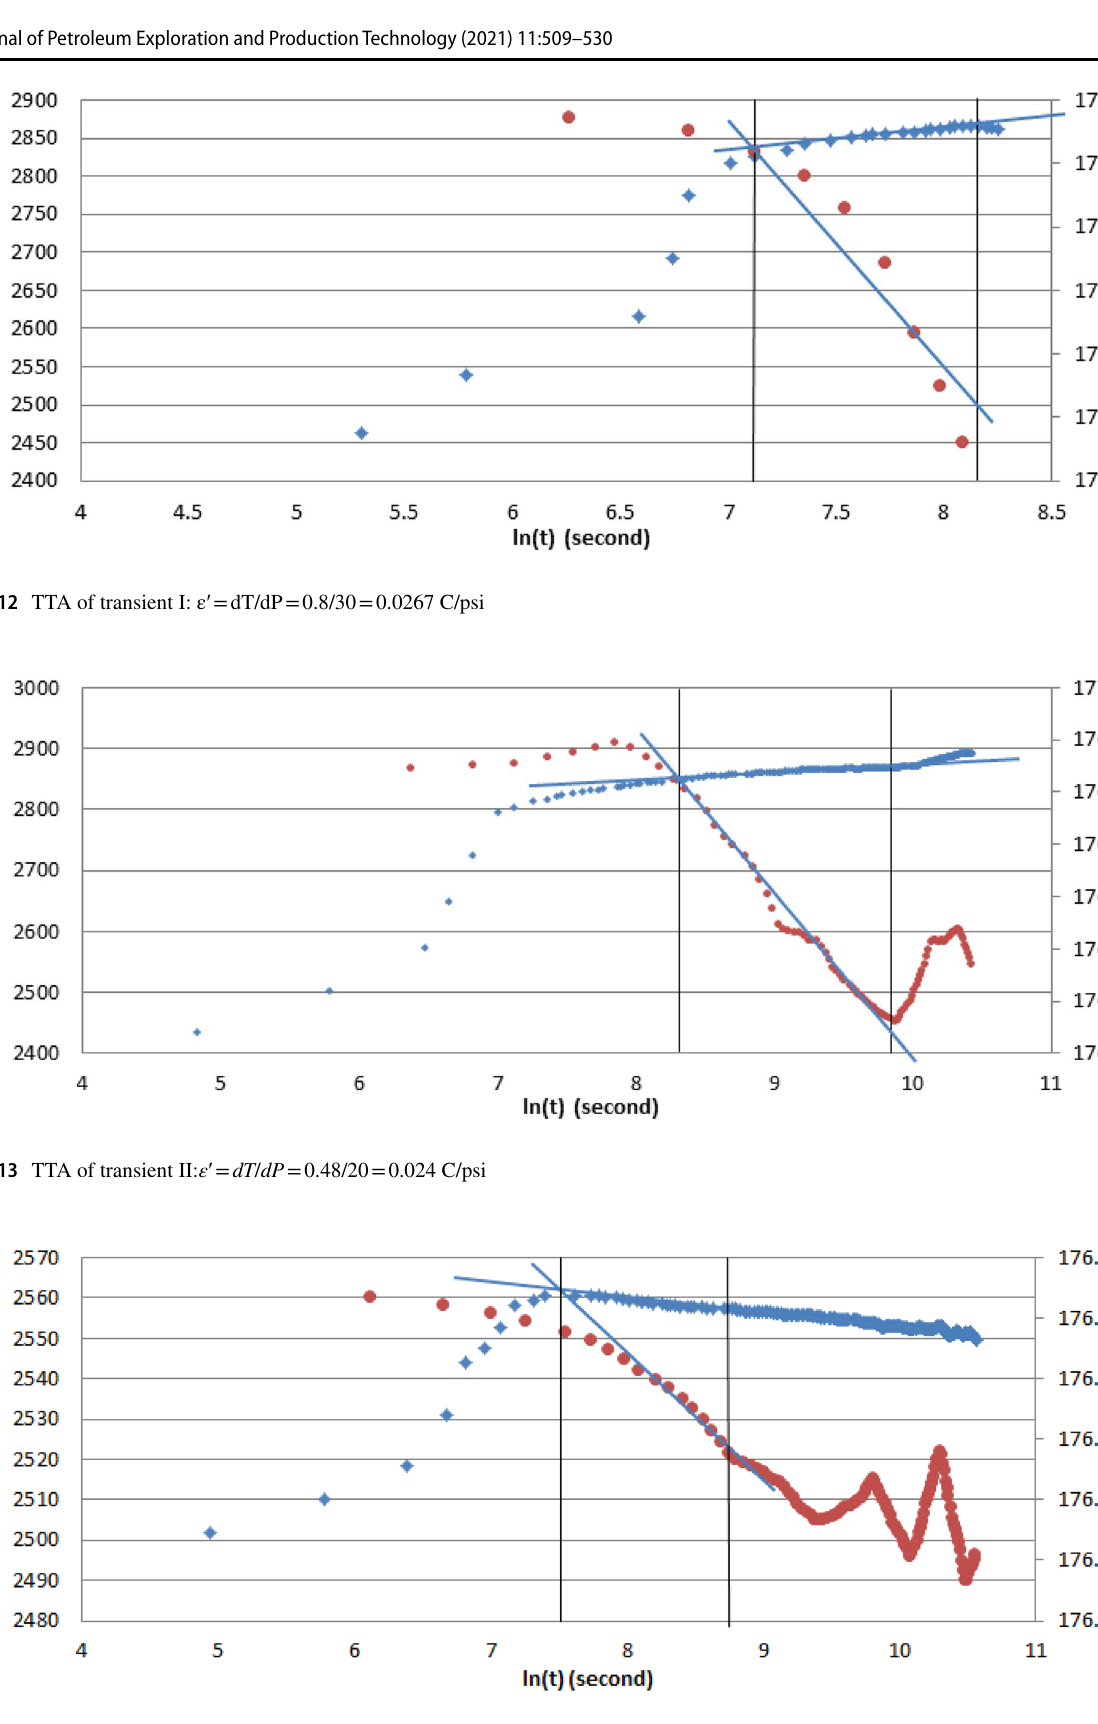
Fig. 14 TTA of transient III: ε ′ = dT / dP = 0.13/5 = 0.026